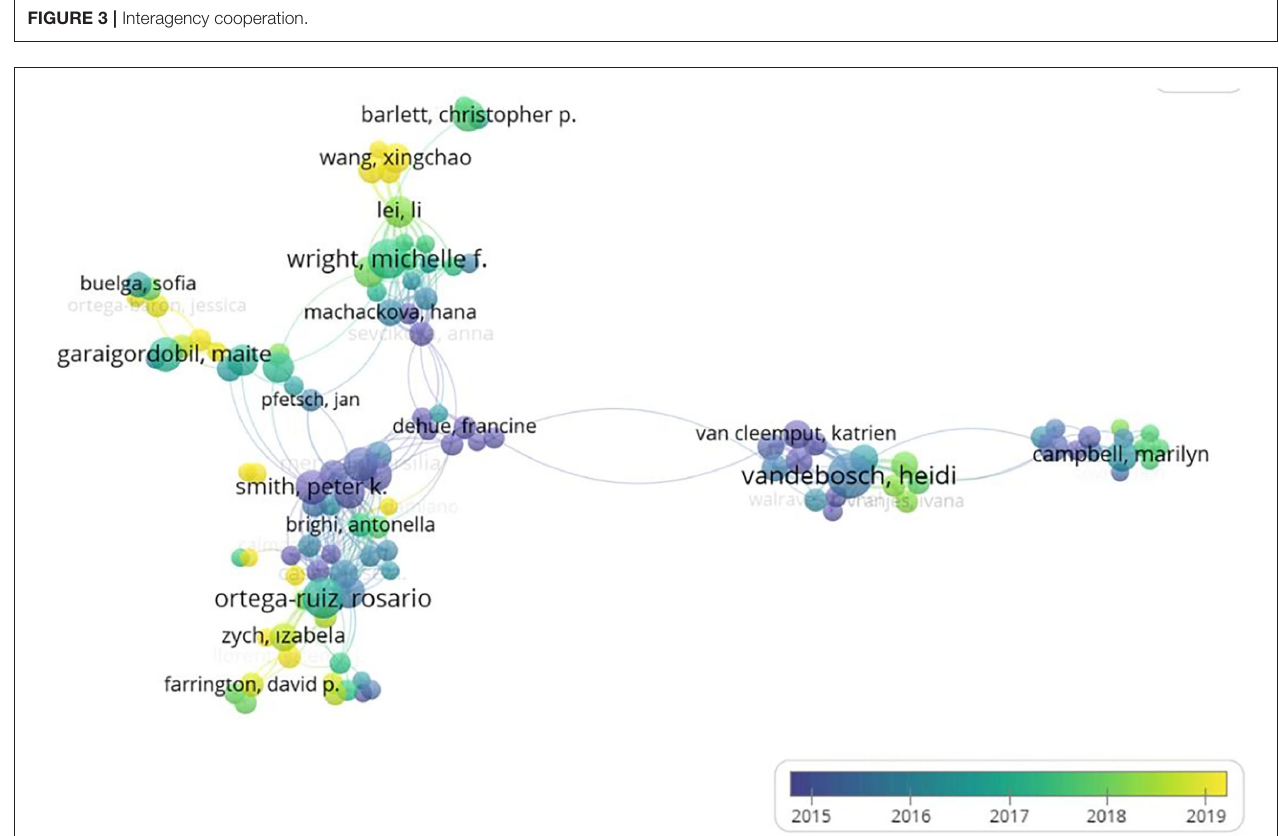
FIGURE 4 | Inter-author